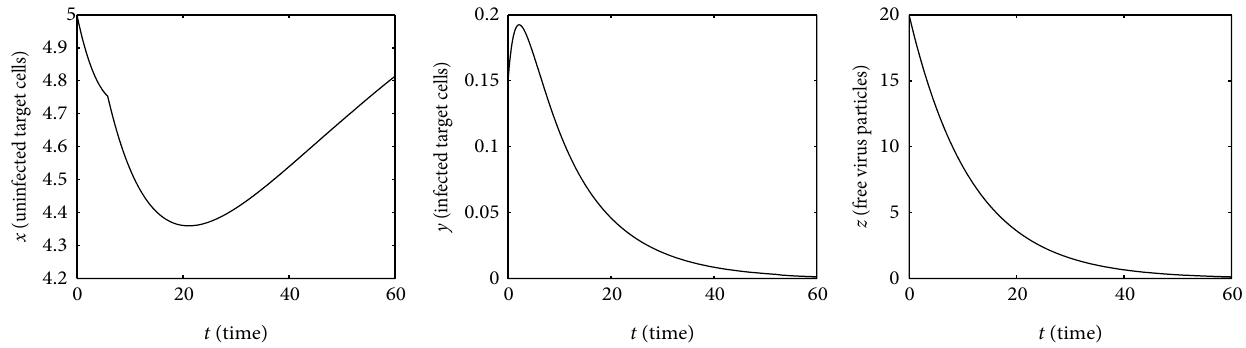
Figure 3: Optimal solutions for 푇 = 60.0 : 푥